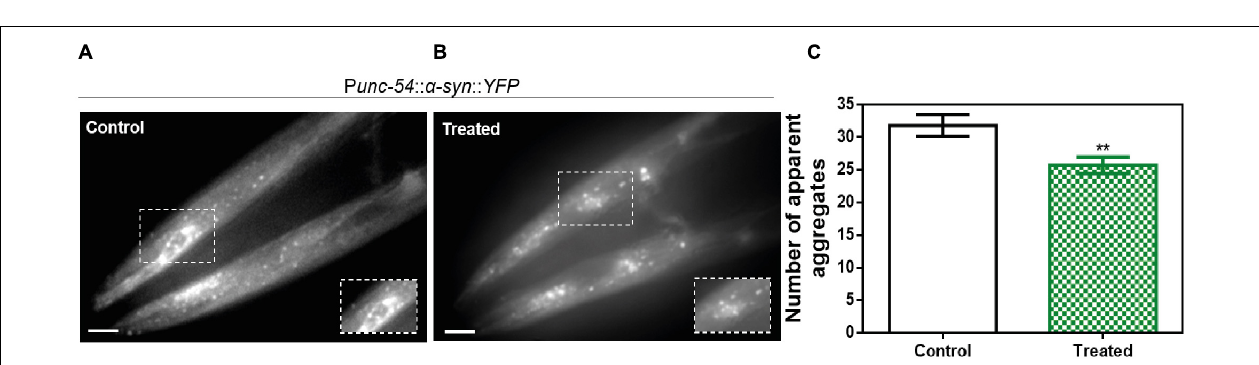
FIGURE 7 | Seeding assays with three different strains. (A,B) Aggregation kinetics of α -Syn, buffer B (50 mM Tris–HCl pH 7.0) (A) , or buffer C (50 mM Tris–HCl pH 7.0 supplemented with 150 mM NaCl) (B) , reported by Th-T fluorescence, in absence of compounds and seeds (black), in presence of 1% (v/v) of preformed seeds at the specific condition (gray dotted line) and in presence of seeds and 100 µ M of ZPD-2 (green). Light dispersion of treated (green) and untreated (white) seeded samples at final point of strain B (C) and strain C (D) . Error bars are shown as standard errors of mean values, ∗∗∗ p < 0.001.